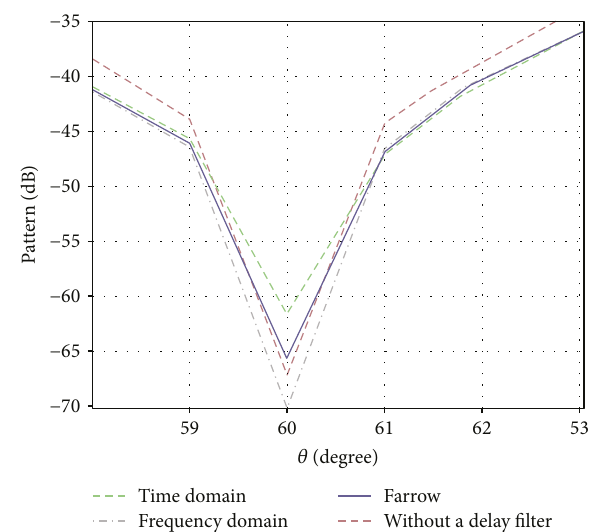
Figure 8: The nulls in the pattern for